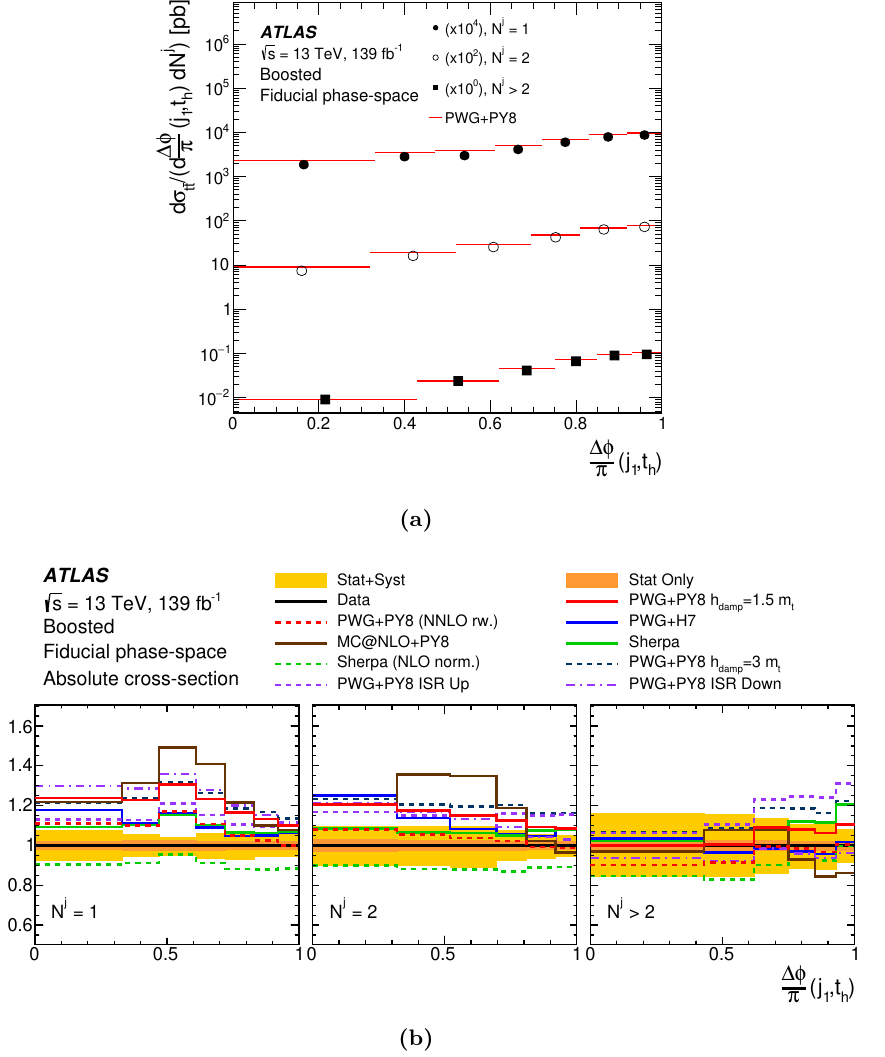
Figure 17. (a) Differential cross-section measurements as a function of the ∆ φ angle between the leading additional jet and the hadronically decaying top quark in bins of additional jet mul- tiplicity are compared with the prediction from the Powheg+Pythia MC generator. The mea- surement and the predictions are normalised by the factors shown in parentheses to aid visibil- ity. (b) Ratio of the measured absolute cross-section to different NLO, and NLO reweighted to NNLO, predictions of t ¯ t signal for the same differential variables. PWG+PY8 corresponds to the Powheg+Pythia sample, PWG+H7 to the Powheg+Herwig sample and MCatNLO+PY8 to the MadGraph5_aMC@NLO+Pythia sample. The yellow band represents the total uncertainty of the measured differential cross-section while the orange band shows the statistical